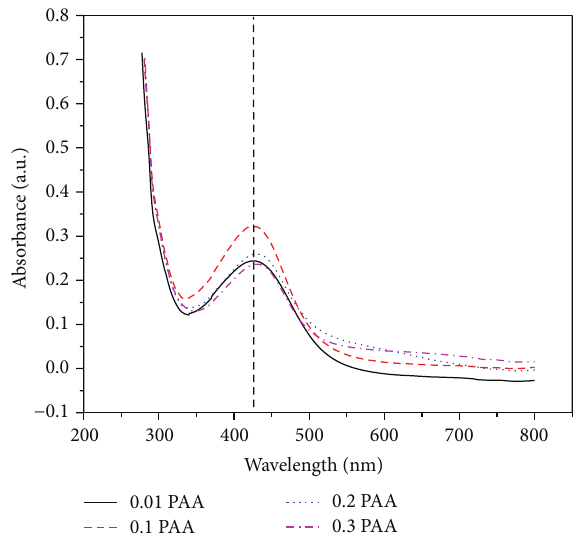
Figure 4: UV-Vis spectrum of as-prepared Ag-NPs in dependence on different concentrations of PAA.